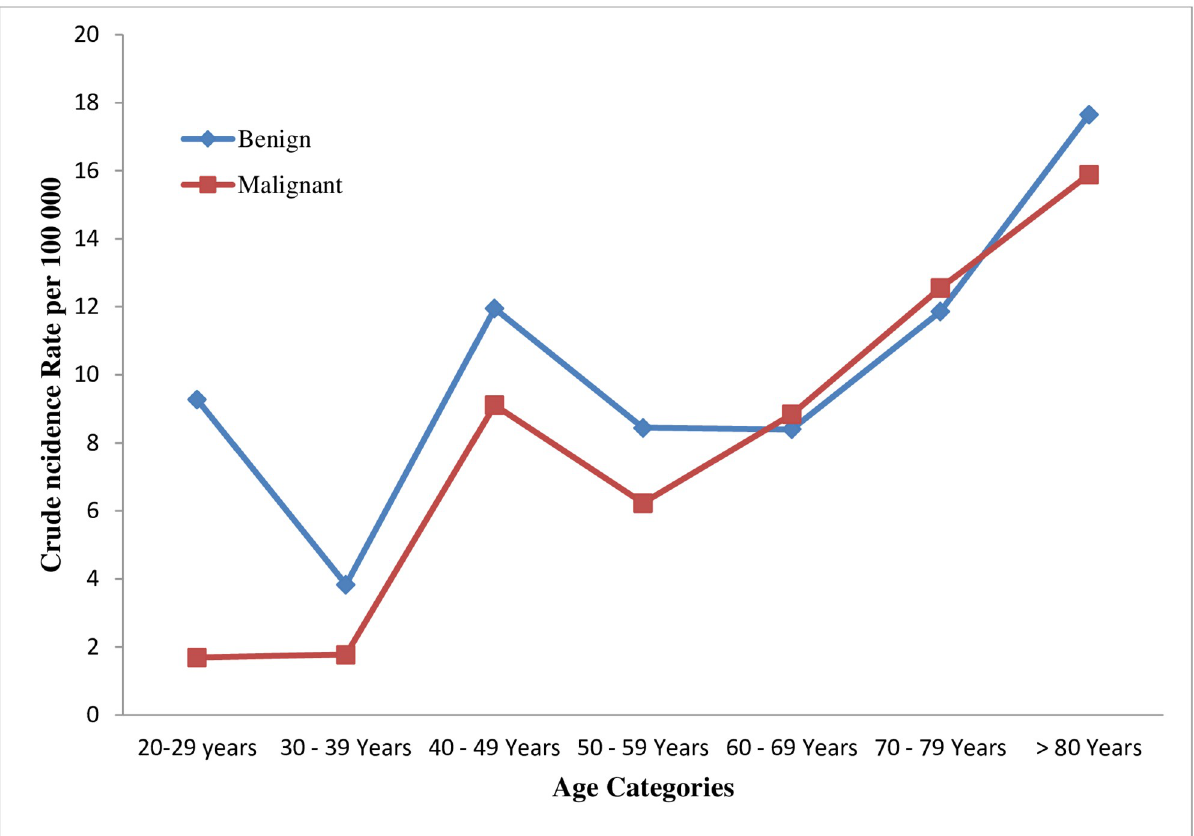
Fig 2. Crude incidence rate of colorectal cancers across different age categories.